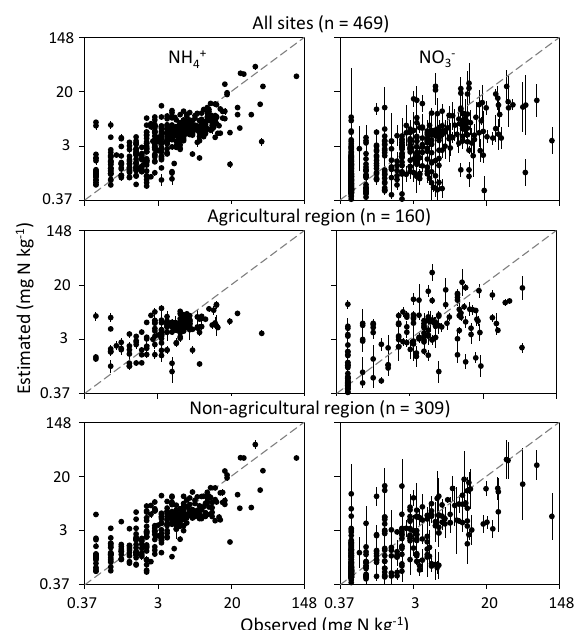
Figure 3. Importance of soil attributes as the predictors of NH and NO − contents (mgNkg − 1 ). The importance of the predictors 3 is based on the usage of each variable in the rule conditions (grey bars) and in the Cubist model (black bars). The abbreviations used are CEC (effective cation exchange) and AWC (available water ca- pacity).